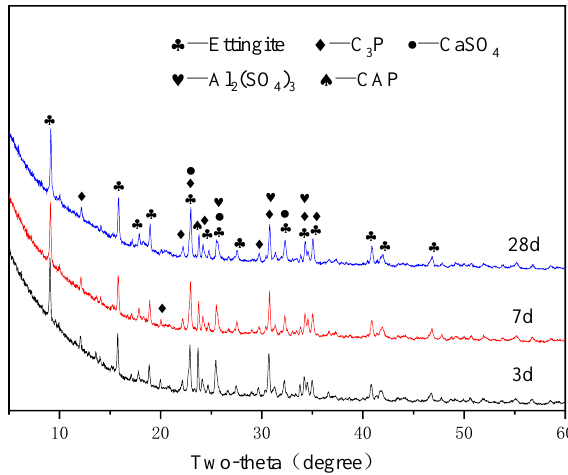
Figure 6. XRD patterns of APC paste for G1 group at different ages.